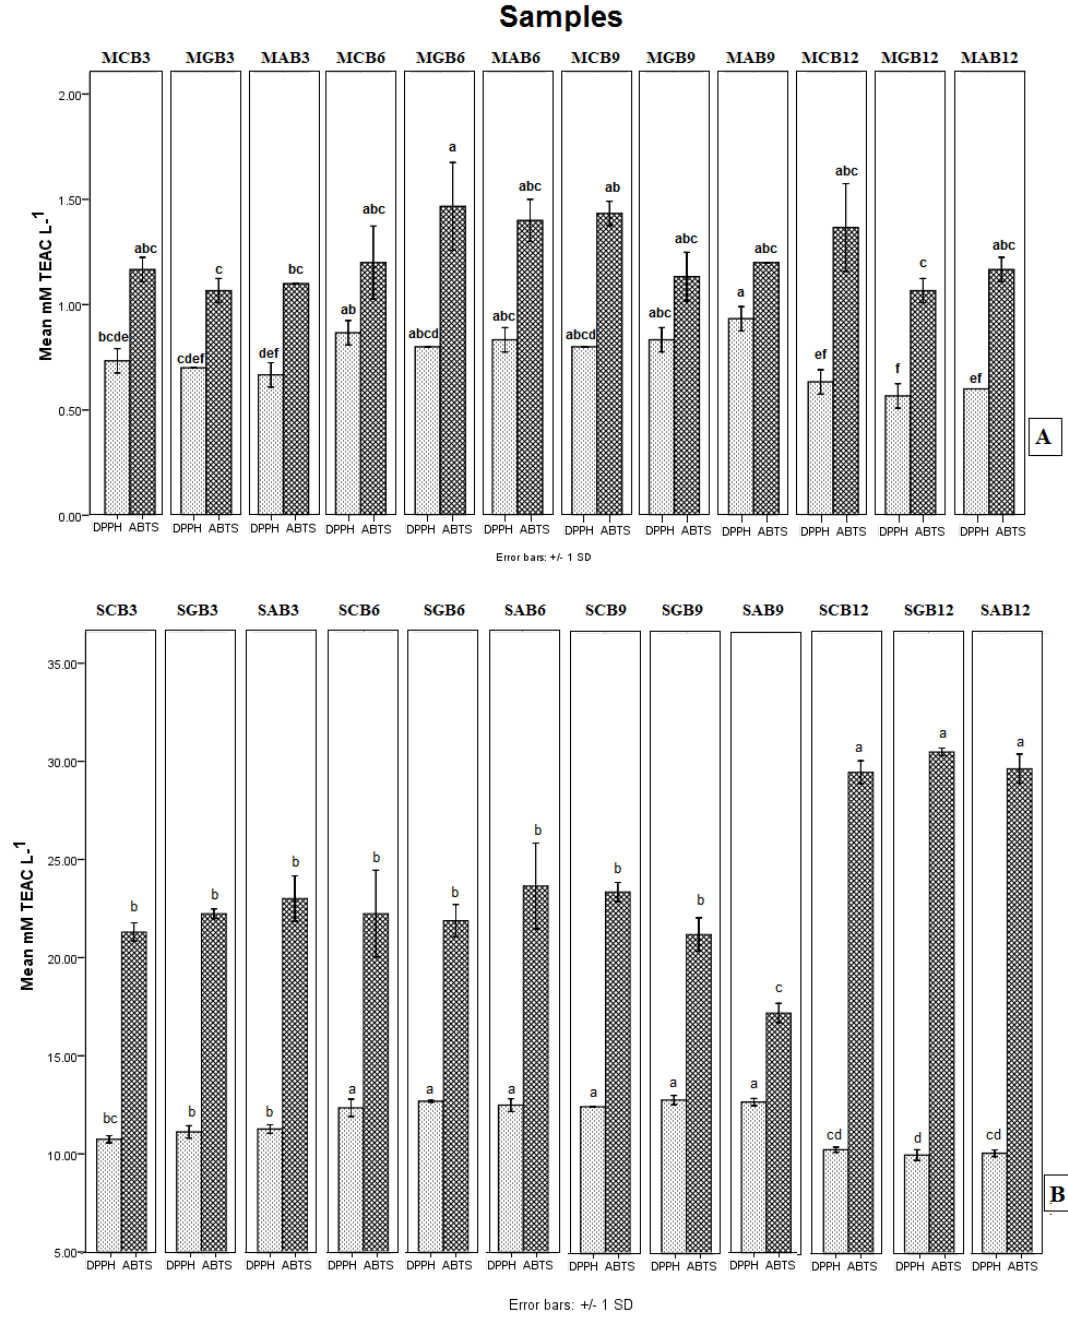
Figure 2. Antioxidant activity in vitro of the sparkling Moscatel ( A ) and Syrah ( B ) wines stored in bottles of different colors for 12 months. DPPH: 2,2-diphenyl-1-picrylhydrazyl; ABTS: 2,2′-azino-bis (3-ethylbenzothiazoline-6-sulfonic acid).